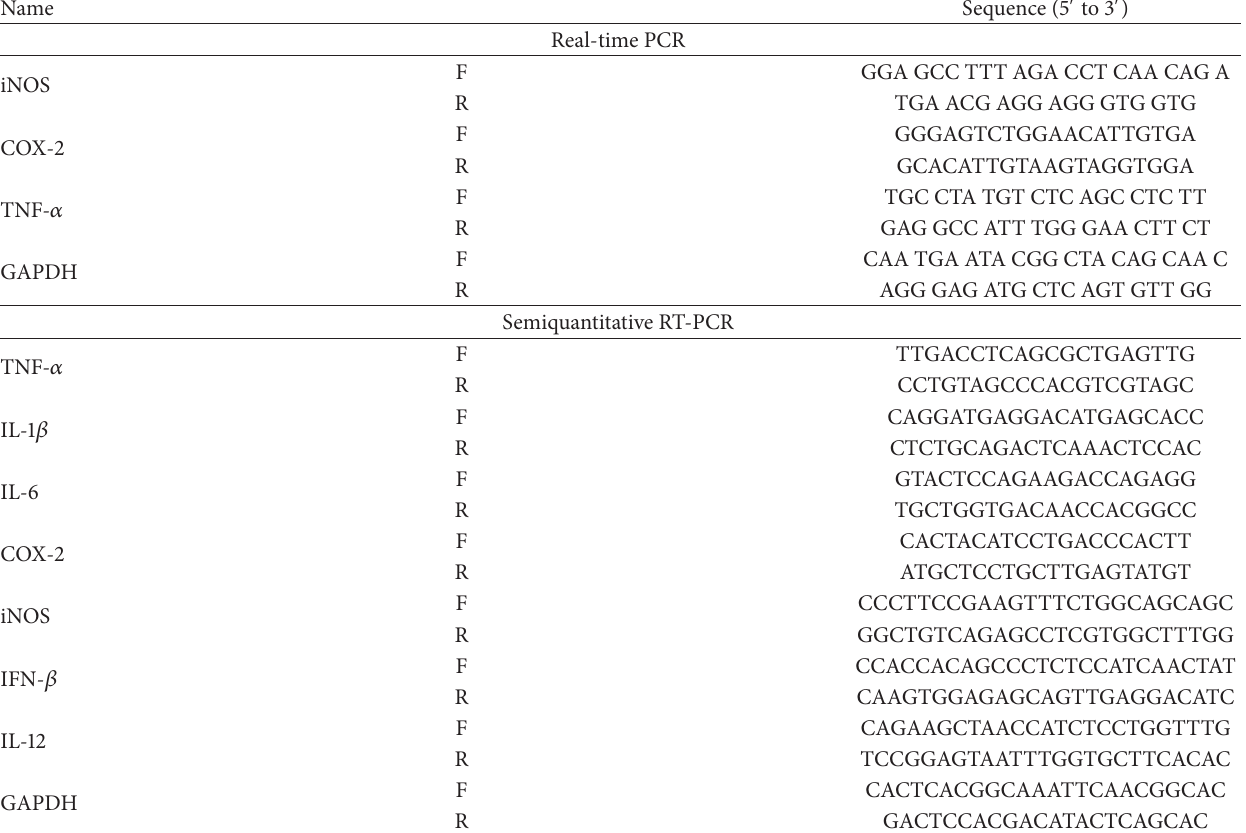
Table 1: Sequences of primers used in semiquantitative and real-time PCR